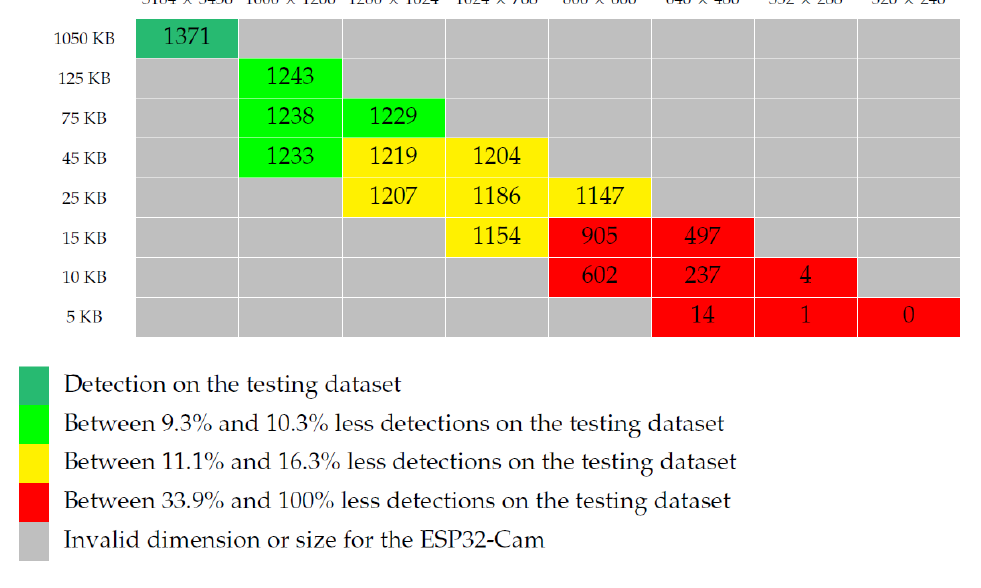
Figure 7. YOLOv5 (XLarge) performance (number of whitefly detections) for different image dimen- sions and